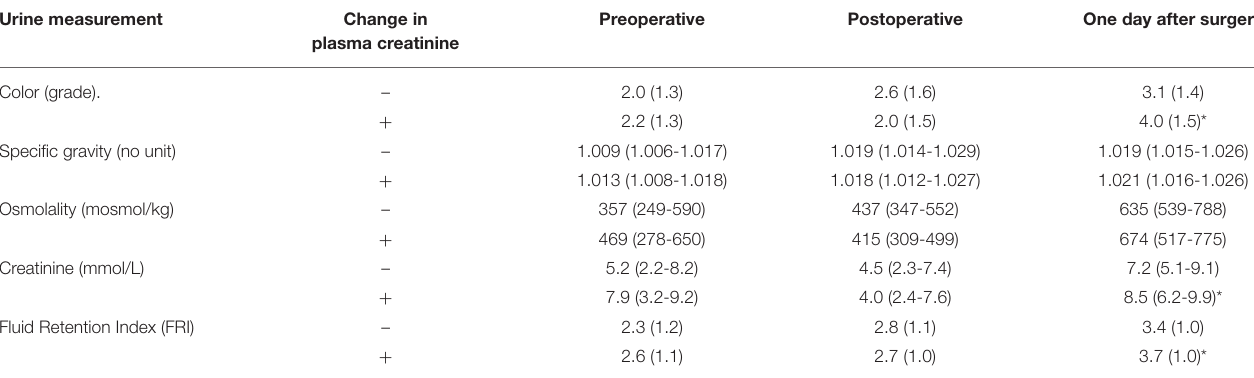
TABLE 5 | Urinary measurements relating to dehydration depending on whether patients had a perioperative decrease (–) or increase ( + ) in plasma creatinine. Urine